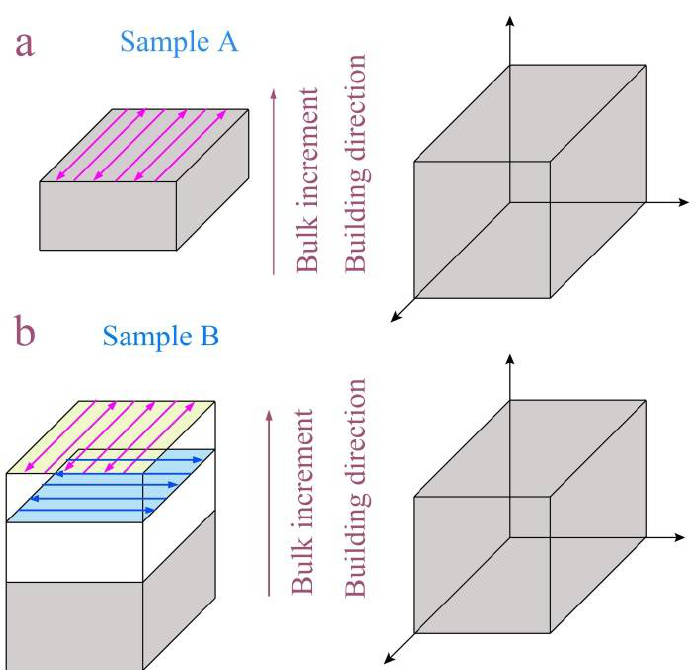
Figure 2. Schematic diagrams of building direction for PBF-EB AM Ti6Al4V alloys: ( a ) Sample A is horizontal back and forth linear scanning without rotation on the next layer; ( b ) Sample B is horizontal back and forth linear scanning with a 90° scan vector rotation on the next layer.